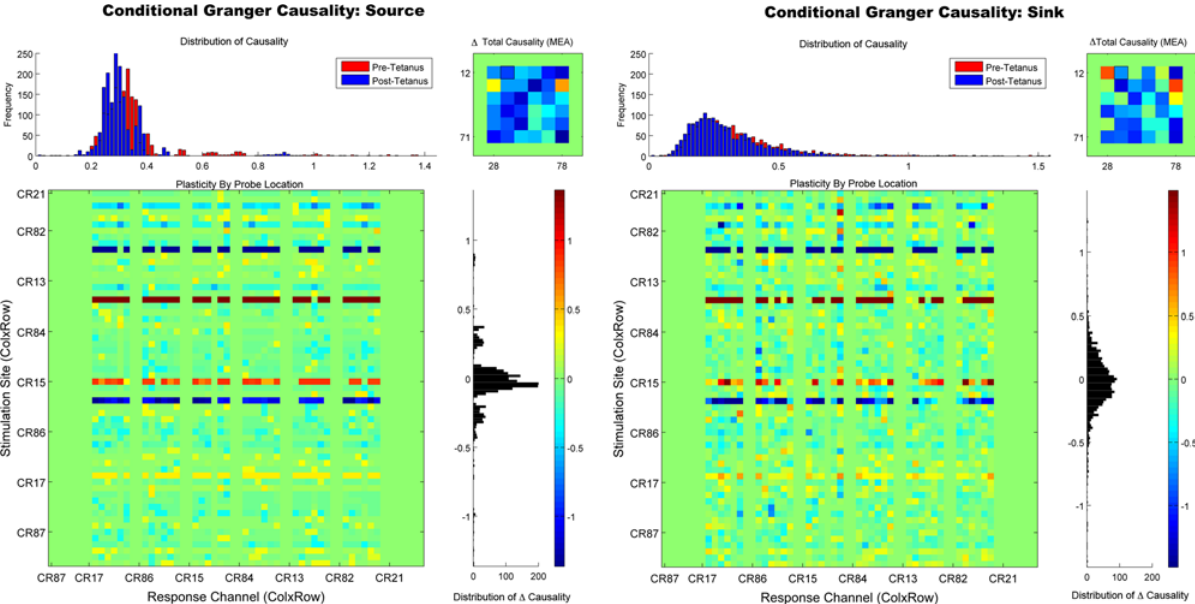
Figure 10. Refinement of Connectivity Patterns With Conditional Granger Causality. Conditional Granger causality was applied to the center block of electrodes (excluding border electrodes) to illustrate the effect of removing mediated influences. For the analysis of each probe the causal effect of each electrode upon each target was conditioned by conditioning out the effects of all other electrodes. The left and right panel shows the results of the conditional analysis for the source and sink measure, respectively. Removing erroneous mediation influences from PGC’s causal estimates substantially refined the pattern of causal connections. This is most apparent in the total causality (upper right plots of each panel) where only a few primary electrodes remain, electrodes which may represent the major pathways that were modified by the tetanus.